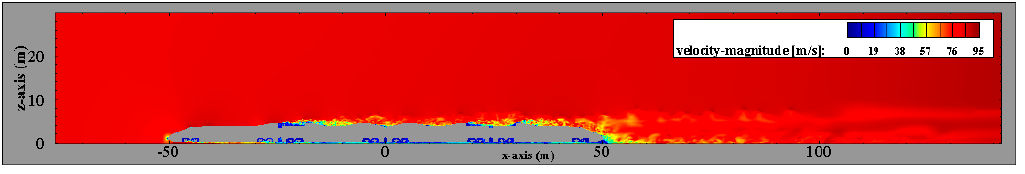
Figure 6. Instantaneous velocity magnitude contour of open field case.